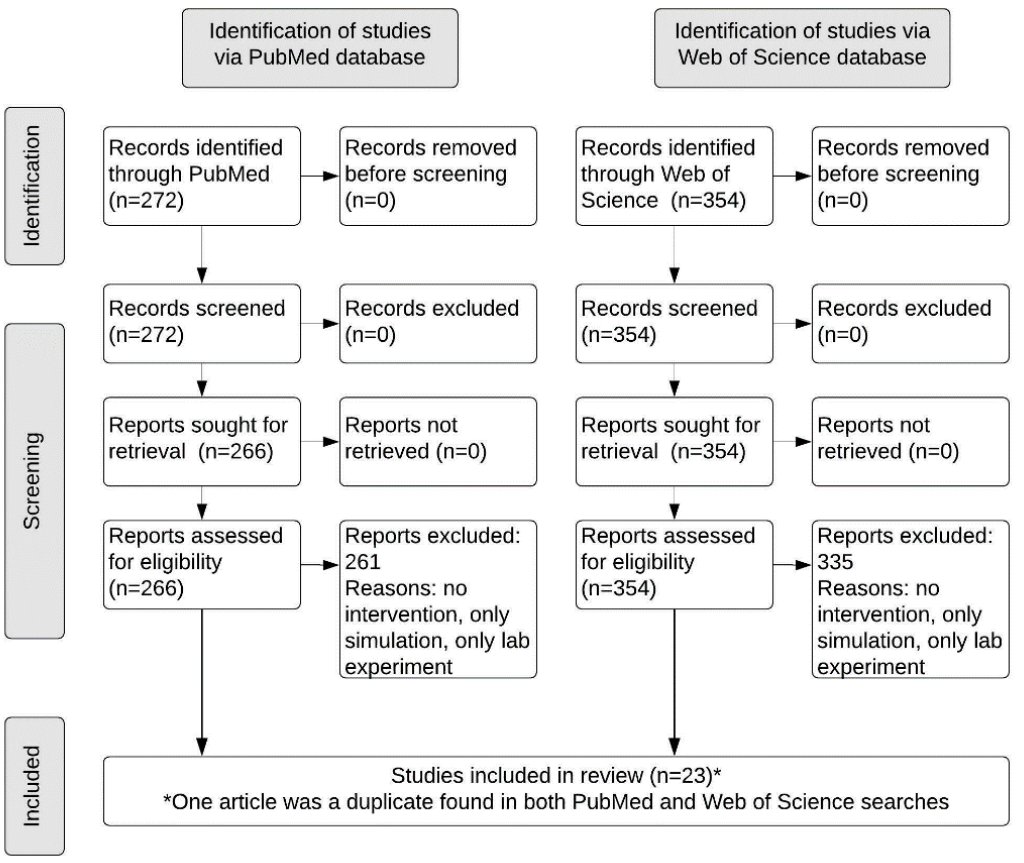
Figure 1. PRISMA flow diagram. Table 1. Summary of evaluation metrics and results from cool pavement intervention